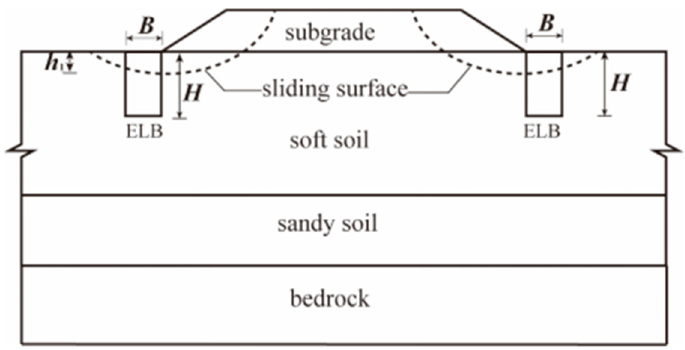
Figure 3. Diagram of the subgrade shear failure mode.